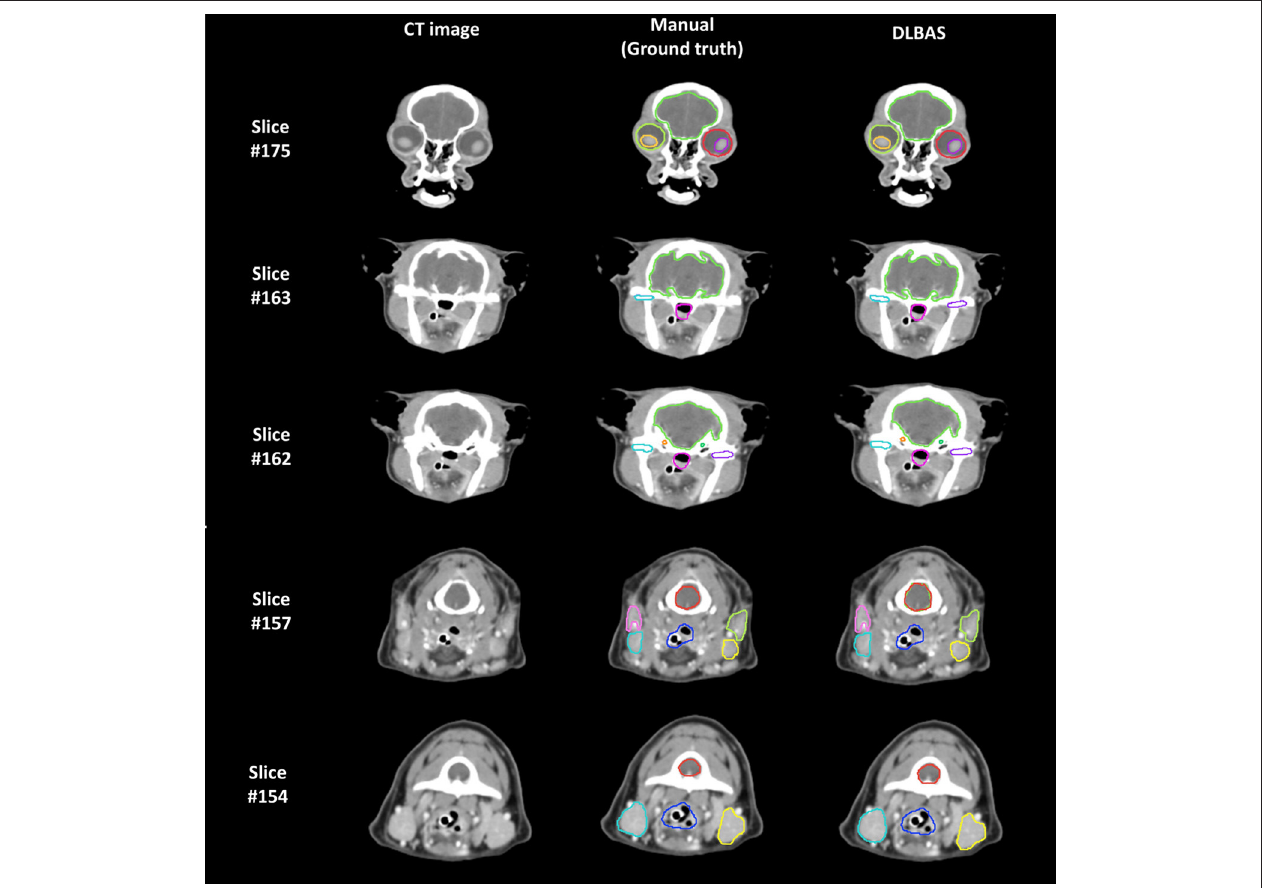
FIGURE 3 | Examples of the ground truth and deep-learning-based automatic segmentation in a test set (DLBAS). Segmentations can be identified in each slice. For the DLBAS, it is difficult to identify a significant difference. Slice #175 shows the eye (red, lime green), lens (yellow, purple), and brain (yellow, green). Slice #163 and #162 show the brain (yellow, green), cochlear (orange, green), temporomandibular joint (sky blue, purple), and pharynx and larynx (pink). Slice #157 and #154 show the mandibular salivary gland (sky blue, yellow), parotid salivary gland (pink, lime green), pharynx and larynx (blue), and spinal cord (red). There are visible differences between the temporomandibular joint (purple) in Slice #163 and the spinal cord (red) in slice #157. Especially, the predicted DLBAS spinal cord (red) region in slice #157 overlapped with the brain